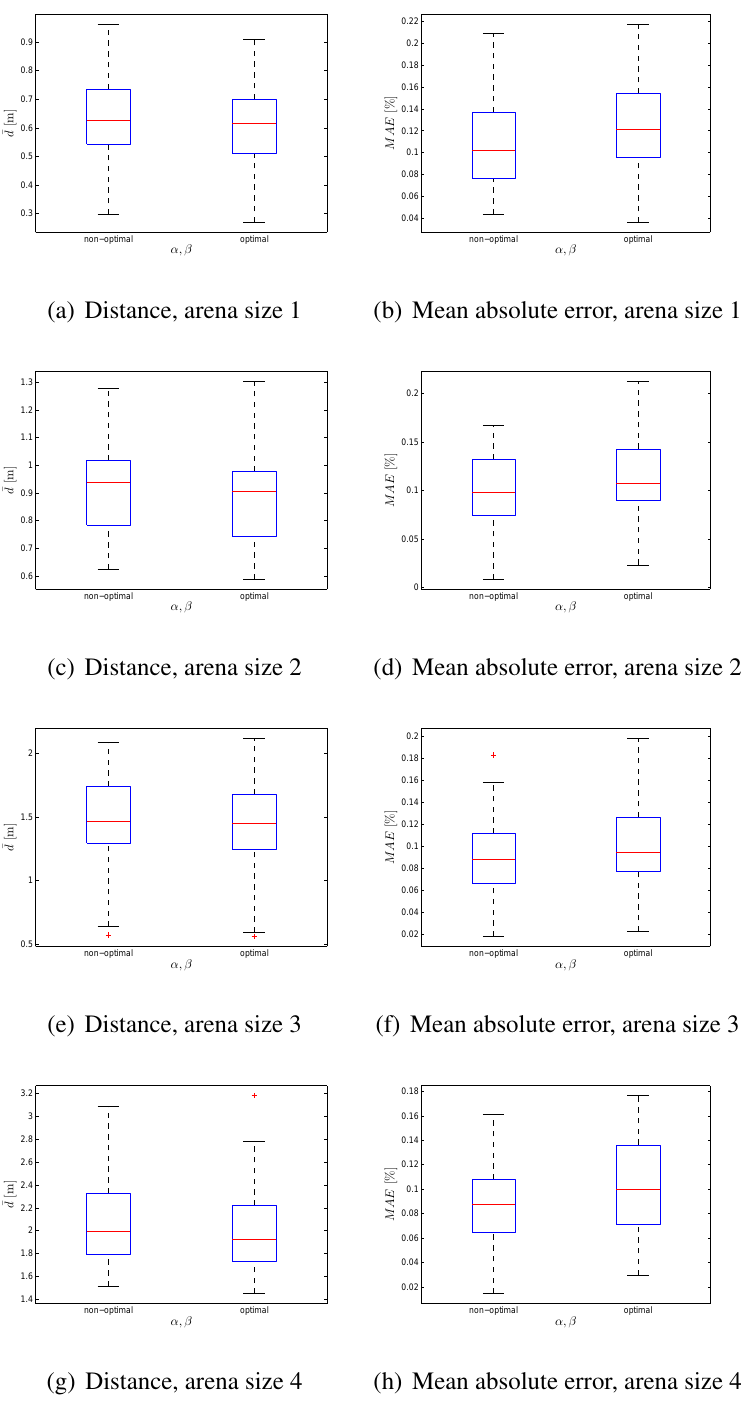
Figure 5. Box-plot comparison for 100 robots and 4 different randomly distributed targets; (cid:11) = (cid:12) = 1 and (cid:11) = 2 : 65 ; (cid:12) = 2 : 55 . Each box-plot comprises observations ranging from the first to the third quartile. The median is indicated by a horizontal bar, dividing the box into the upper and lower part. The whiskers extend to the farthest data points that are within 1.5 times the interquartile range. Outliers are shown with a plus symbol. The values were obtained from 50